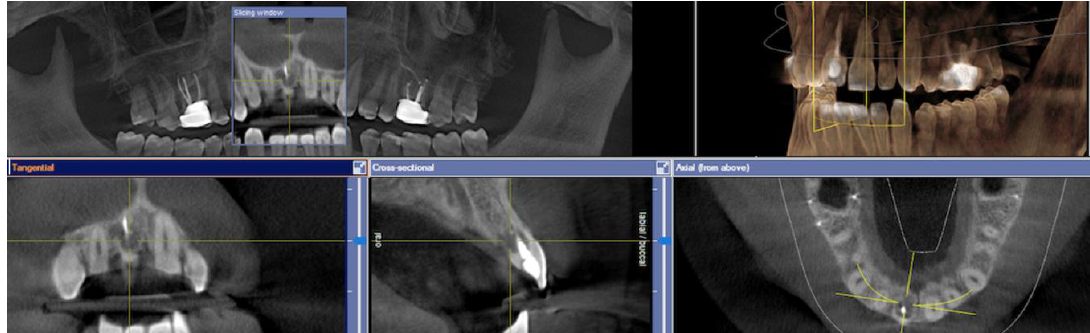
Figure 2. Pre-operative Cone-beam computed tomography systems (CBCT) images; evident resorption of tooth #1.1 and thin buccal plate.